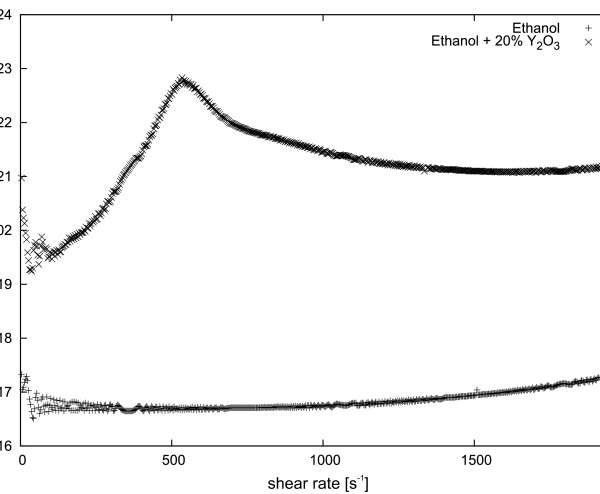
Summary of dynamic viscosity of pure ethyl alcohol and 20 wt. % Y2O3suspension at 10°C.